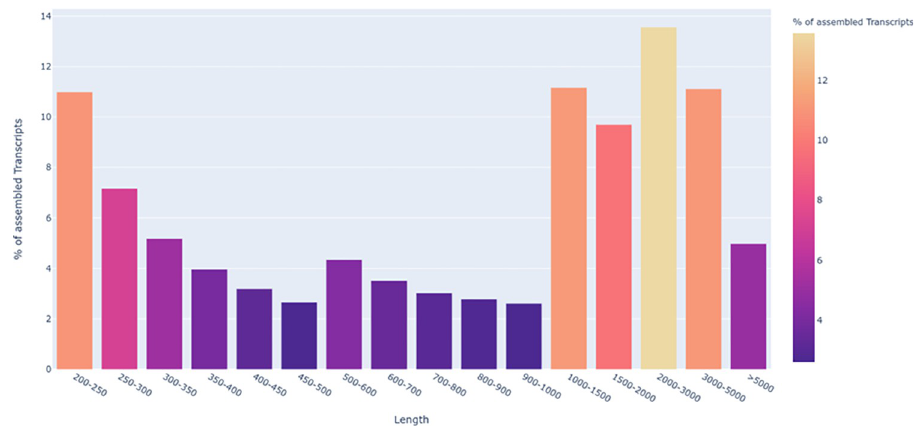
Fig 1. Assembled transcript length distribution of H . indica